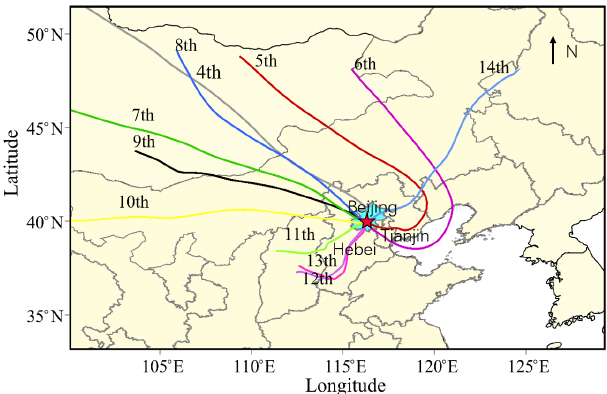
Figure 11. The back trajectories arriving at CAMS station at 12:00LT form 4 to 14 February with the terminal height of